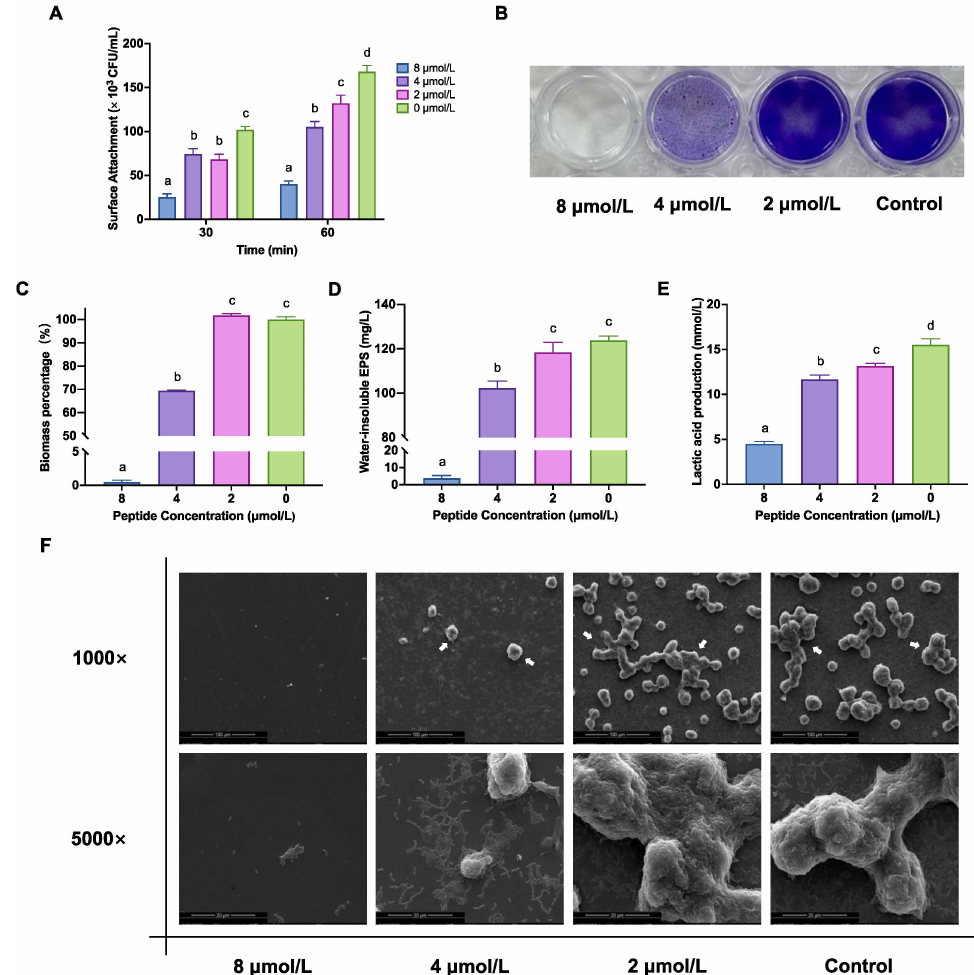
Figure 2. The inhibition of LF-1 on the adhesion and biofilm formation of Streptococcus mutans . LF-1 significantly decreases the surface-attached S. mutans in a concentration-dependent manner. ( A ) The inhibition of LF-1 on S. mutans biofilm formation is visually presented by the representative images of CV-stained biofilms ( B ) and assessed by measuring the biomass percentage ( C ), water-insoluble EPS ( D ), and lactic acid production. ( E ) SEM observations ( F ) further confirm that LF-1 alters the ultrastructural morphology of the S. mutans biofilm with visually reduced extracellular matrix and bacteria. The arrows indicate the bacterial clusters that comprise aggregated S. mutans wrapped in EPS. All data are presented as the mean ± standard deviation from at least three independent experiments, and relative values are obtained by comparison with the untreated control. Columns labelled with different superscript letters denote significant statistical differences in one group (one- or two-way analysis of variance; p < 0.05). CV: crystal violet; EPS: exopolysaccharide; SEM: scanning electron